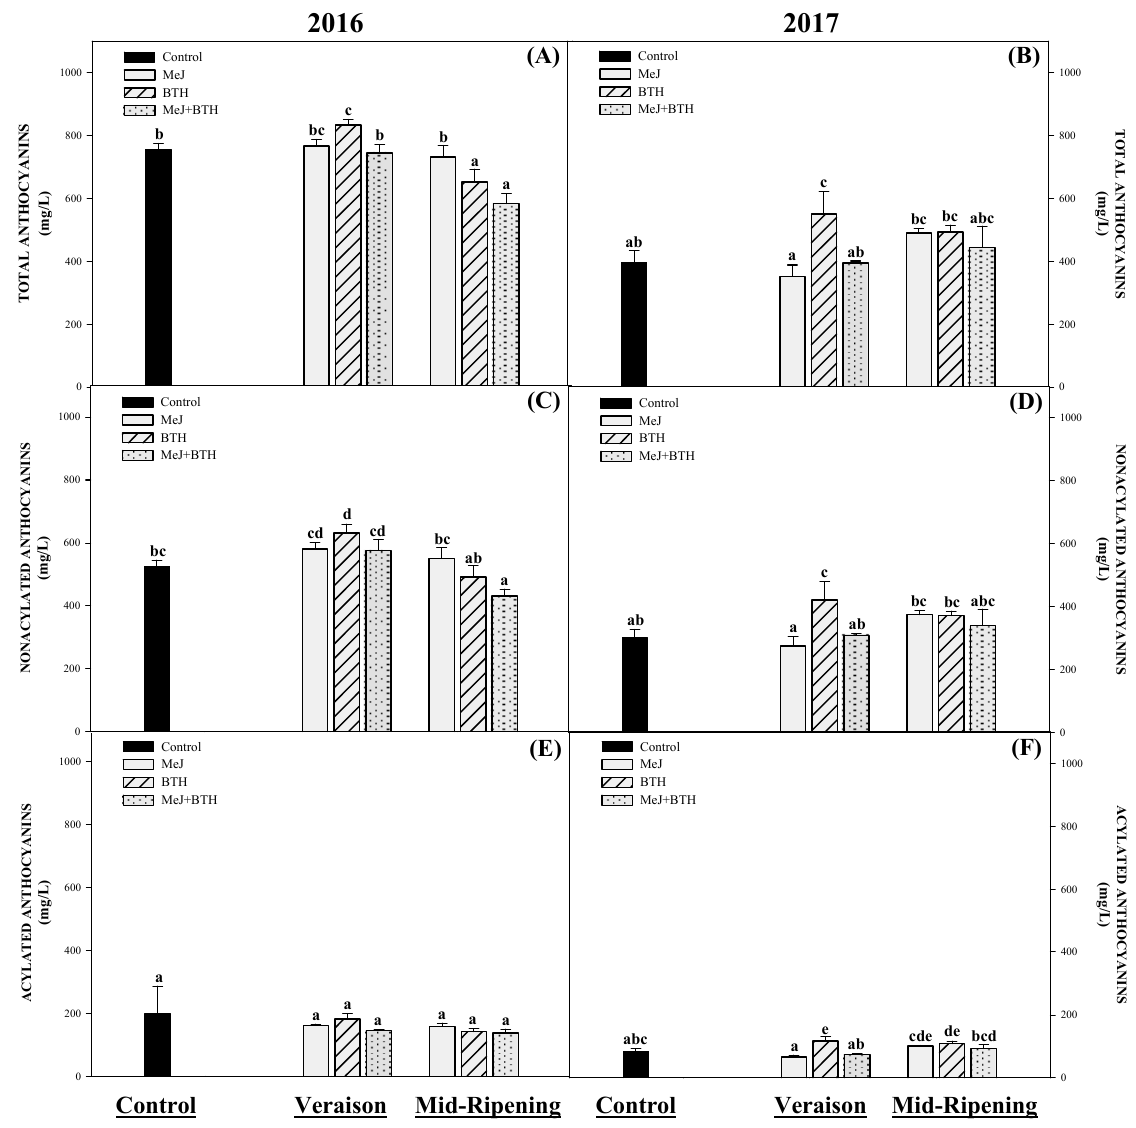
Figure 2. Concentration of anthocyanins measured by HPLC in Monastrell wines (expressed as mg/L) made from grapes treated with MeJ, BTH, or MeJ + BTH at two different times: veraison and mid-ripening. Different letters indicate significant differences according to Duncan’s test ( p < 0.05). Table 3. Concentration of anthocyanins expressed as mg/L at the end of alcoholic fermentation in Monastrell wines (2016 and 2017).